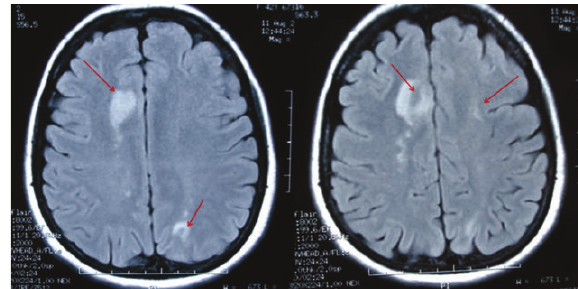
Figure 1: Brain MRI (FLAIR scans) with subacute ischemic lesions in left frontal and bilateral parietal regions.